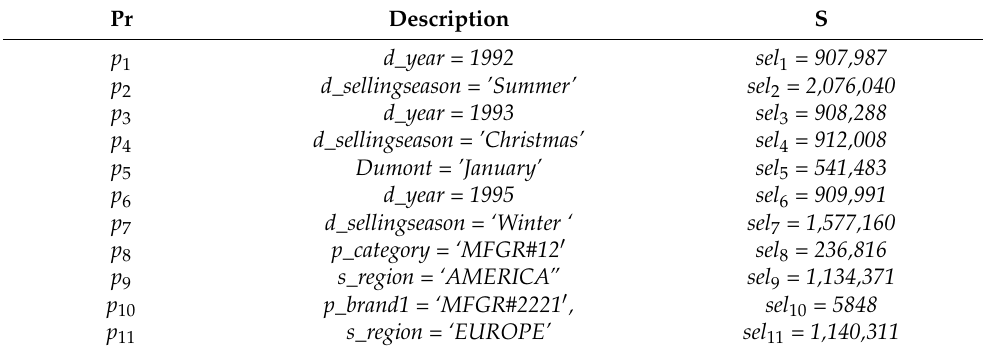
Table 3. Predicates used by the queries.